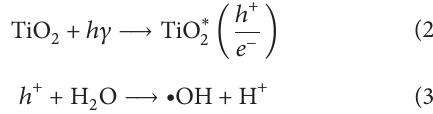
Figure 5: MS spectrum of major oxidation products of